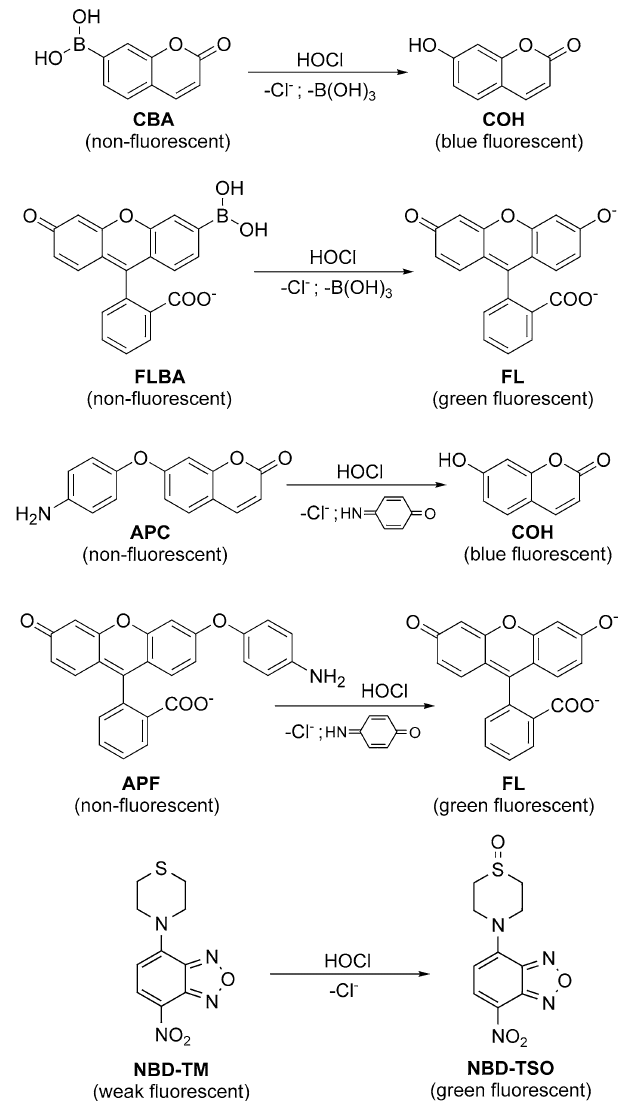
Figure 2. Structures of the investigated probes and their oxidation